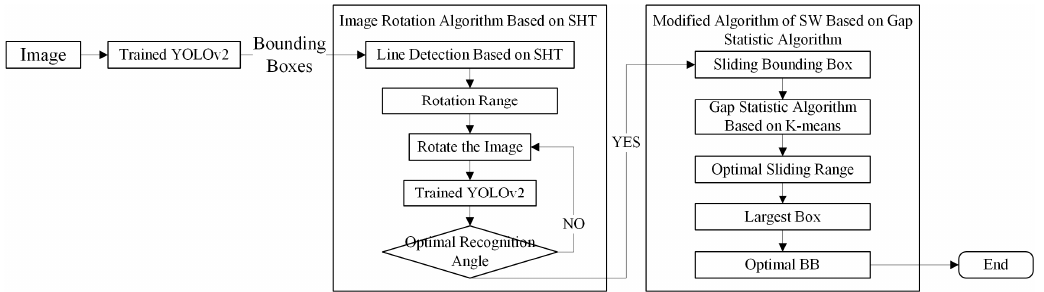
Figure 2. Our proposed algorithm flow chart.